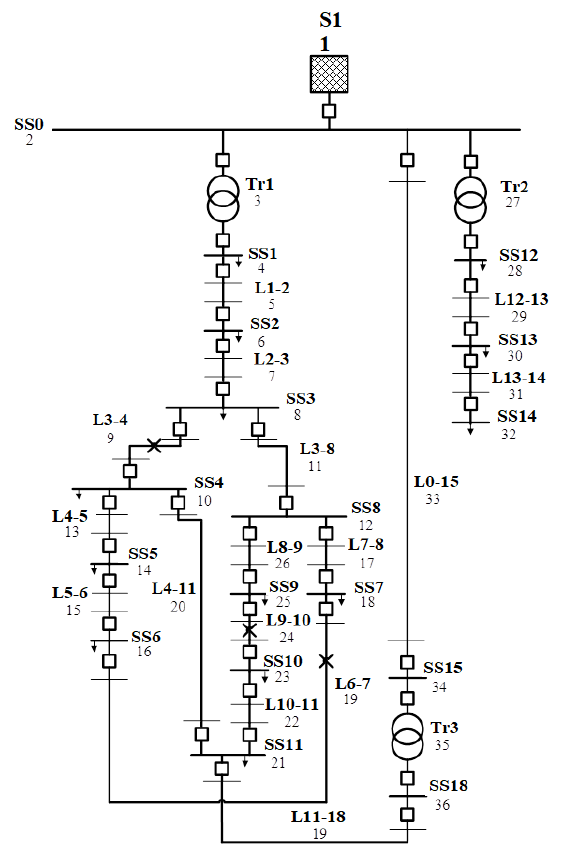
Figure 3. Structure 1 of the distribution network (S—System, Tr—Transformer, L—Line, SS—Substation).